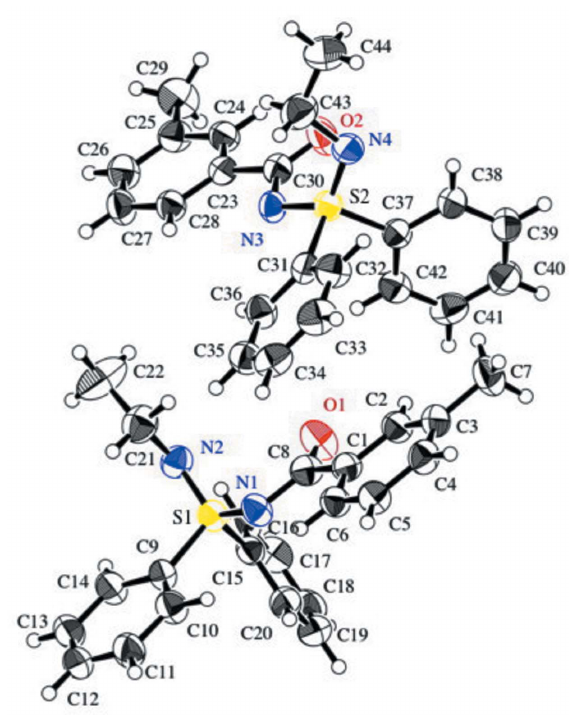
Figure 1 Aview of the two independent molecules of the title compound, with the atom labelling. Displacement ellipsoids are drawn at the 50% probability